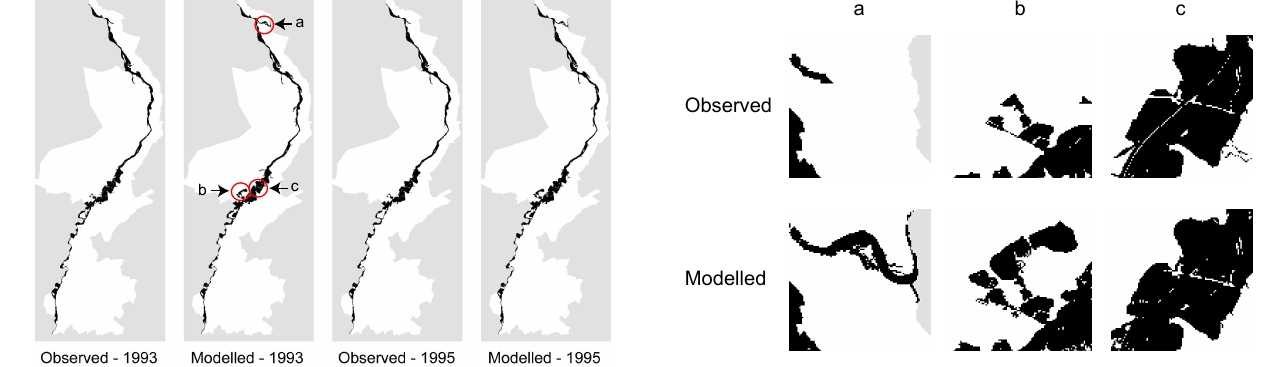
Fig. 4. Inundation extent maps based on aerial photography and satellite imagery (observed) and Floodscanner (modelled) for the floods of 1993 and 1995. The red circles show two locations at which the model did not perform well (a: confluence of the Niers and the Meuse rivers and b: the lake known as the Lange Vlieter, completed post-1995) and a location at which the model performed very well (c).